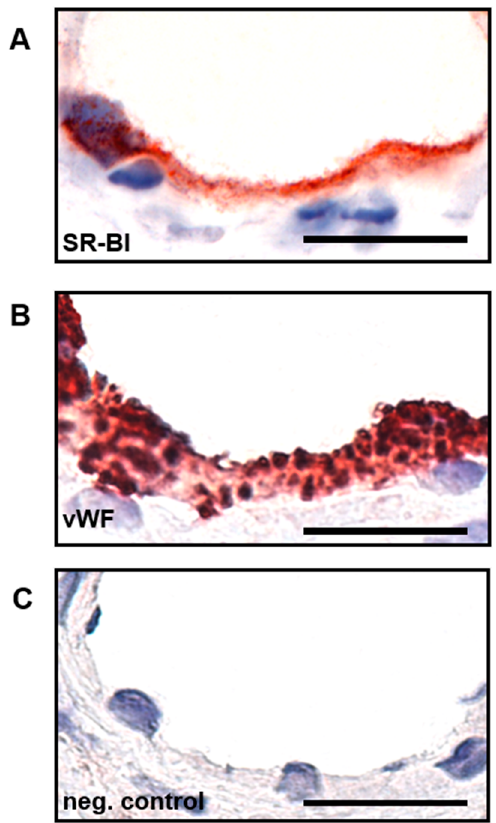
Figure 2. ( A ) Immunohistochemical localization of SR-BI on placental vessels. SR-BI staining (red) is strong on the apical side of the endothelium, whereas in the cytoplasm only a weak signal is detectable. SR-BI is not present on the basal side. ( B ) von Willebrand factor marked EC layer. ( C ) IgG negative control; Bar: 20 µm .